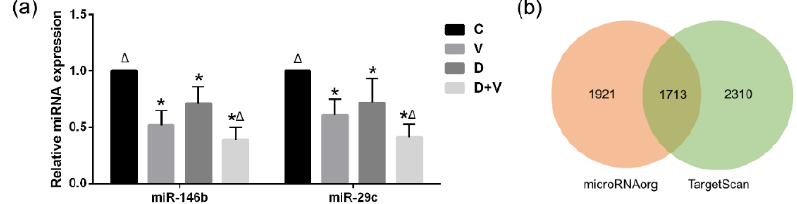
Figure 8. Differential miRNA validation and target prediction. ( a ) MicroRNA expression levels measured by RT-PCR. Data were corrected by the expression level of 18s RNA. The relative expression level was calculated by setting the control group expression level as 1. * p < 0.05 compared with group C; ∆ p < 0.05 compared with group V. ( b ) Venn chart of the predicted target genes discovered by the TargetScan and microRNA.org